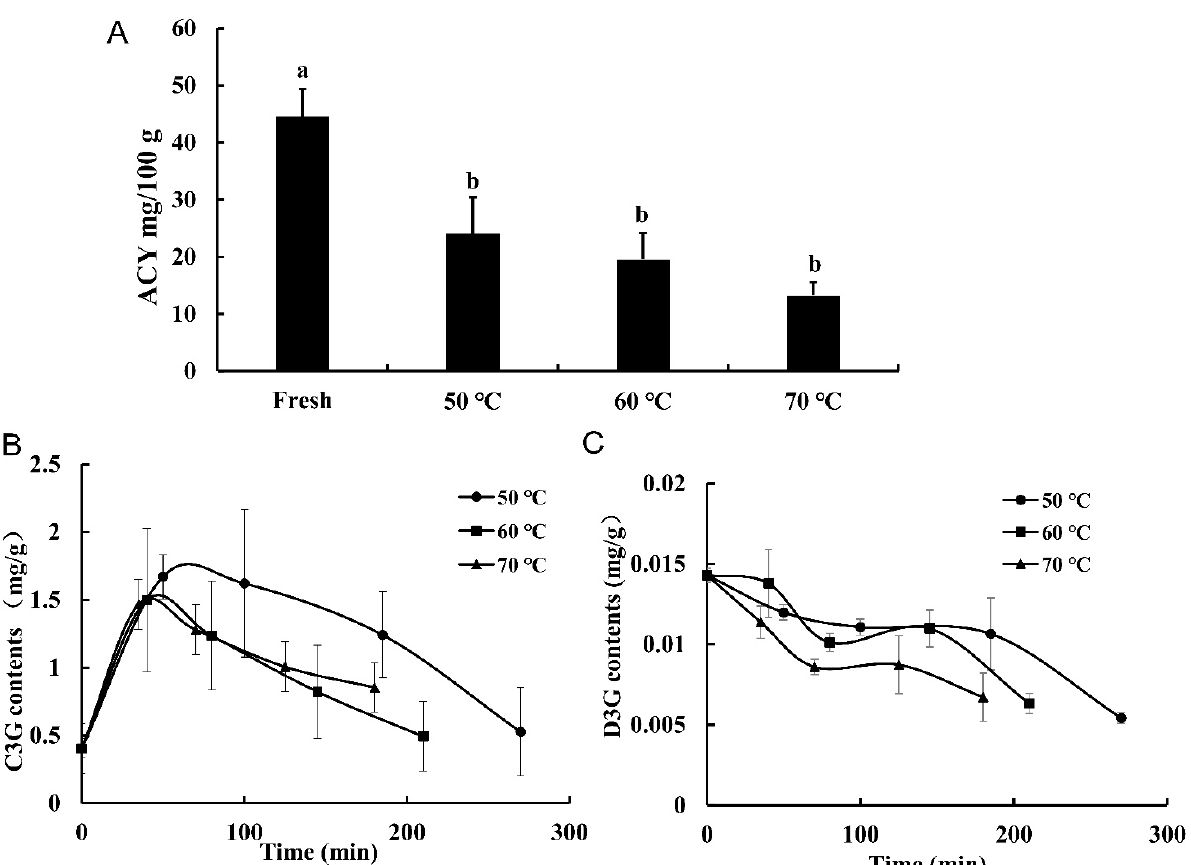
Figure 4. Contents of ACY in the fresh and dried blood-flesh peach ( A ). Degradation curves of cyanidin-3-glucoside (C3G) ( B ) and delphinidin-3-galactoside (D3G) ( C ) of blood-flesh peach during HAD. Values were presented as mean ± sd. Different letters mean significant difference as determined by Tukey’s post hoc test ( p < 0.05).